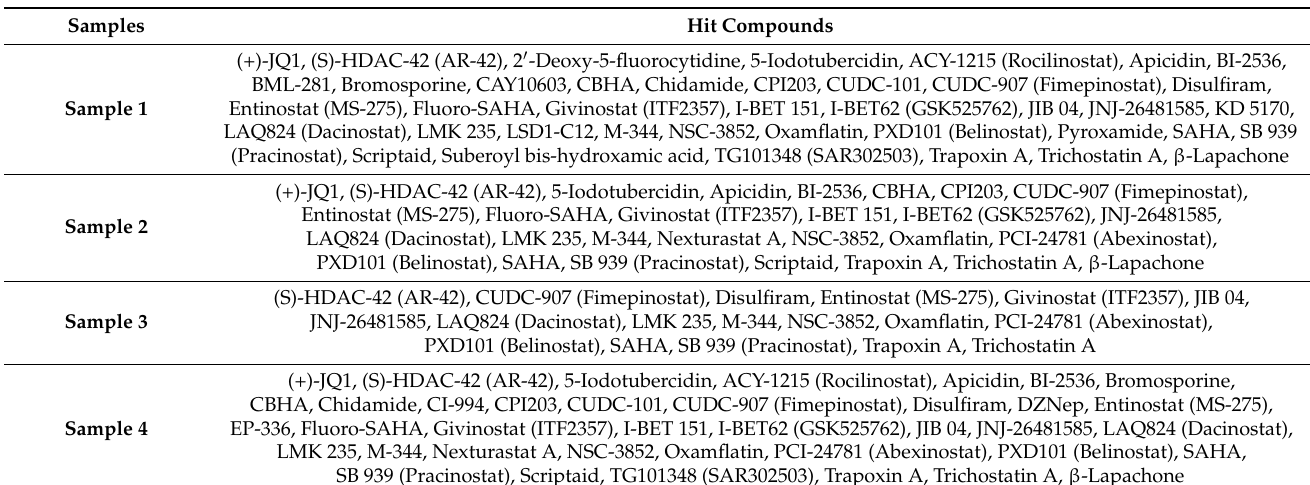
Table 2. Treatment responses in individual